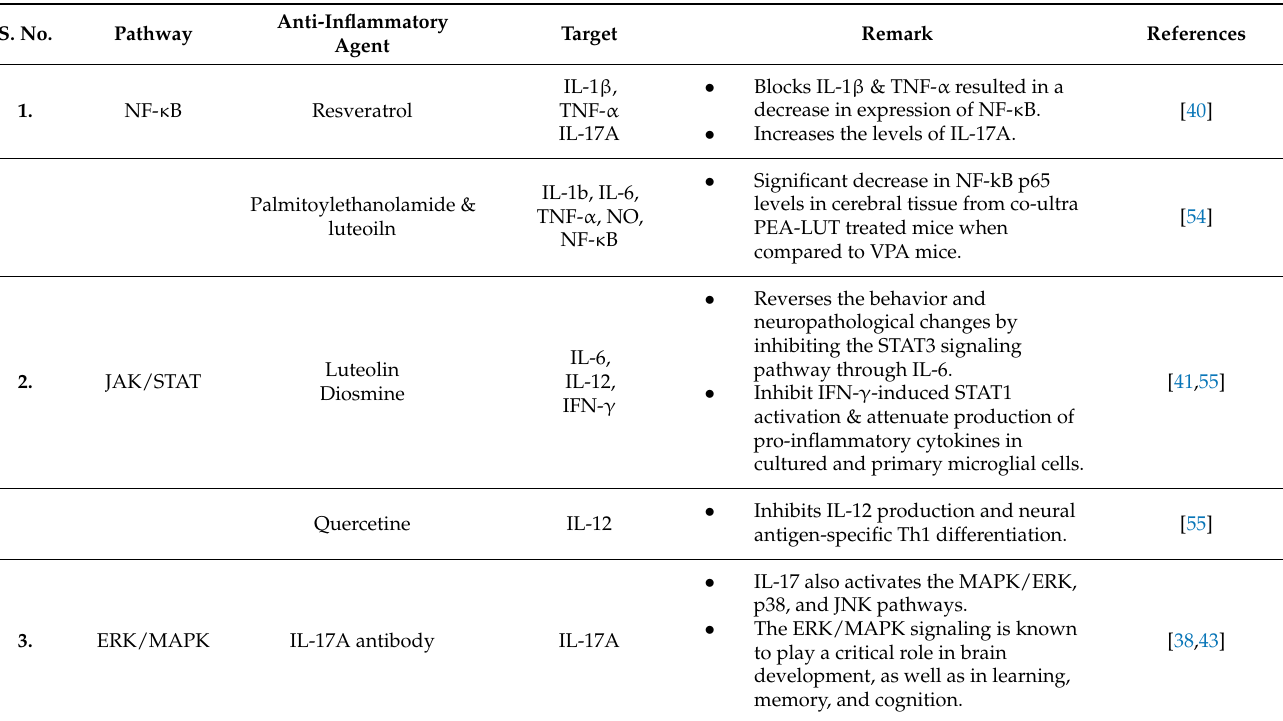
Table 1. Preclinical studies related to natural anti-inflammatory agents targeting inflammatory pathways for ASD